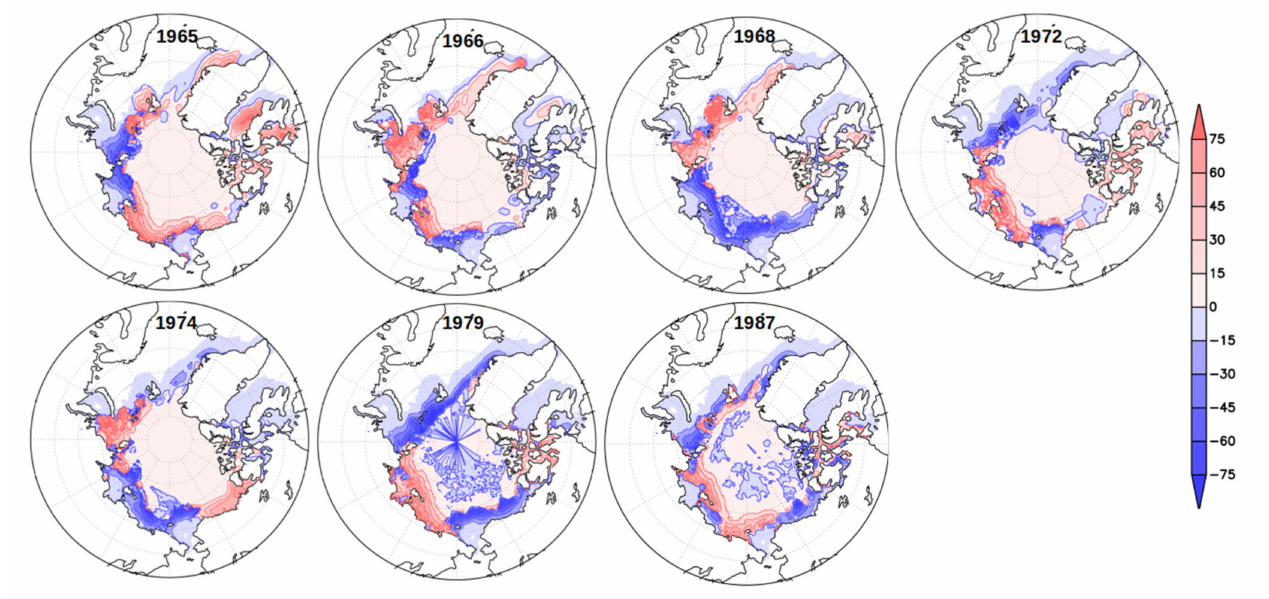
Figure 3. September Arctic sea-ice concentration (%) anomalies during weak ISM